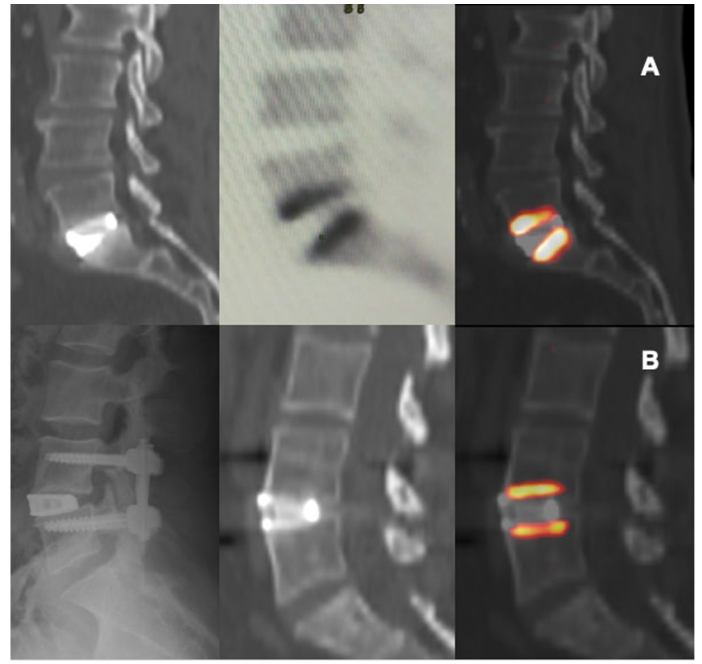
Figure 4. CT and PET images showing metabolic activity on vertebral plates after arthrodesis surgery with trabecular titanium cage. L5-S1 ALIF, 11 weeks ( A ); L4-L5 XLIF, 27 weeks ( B ).